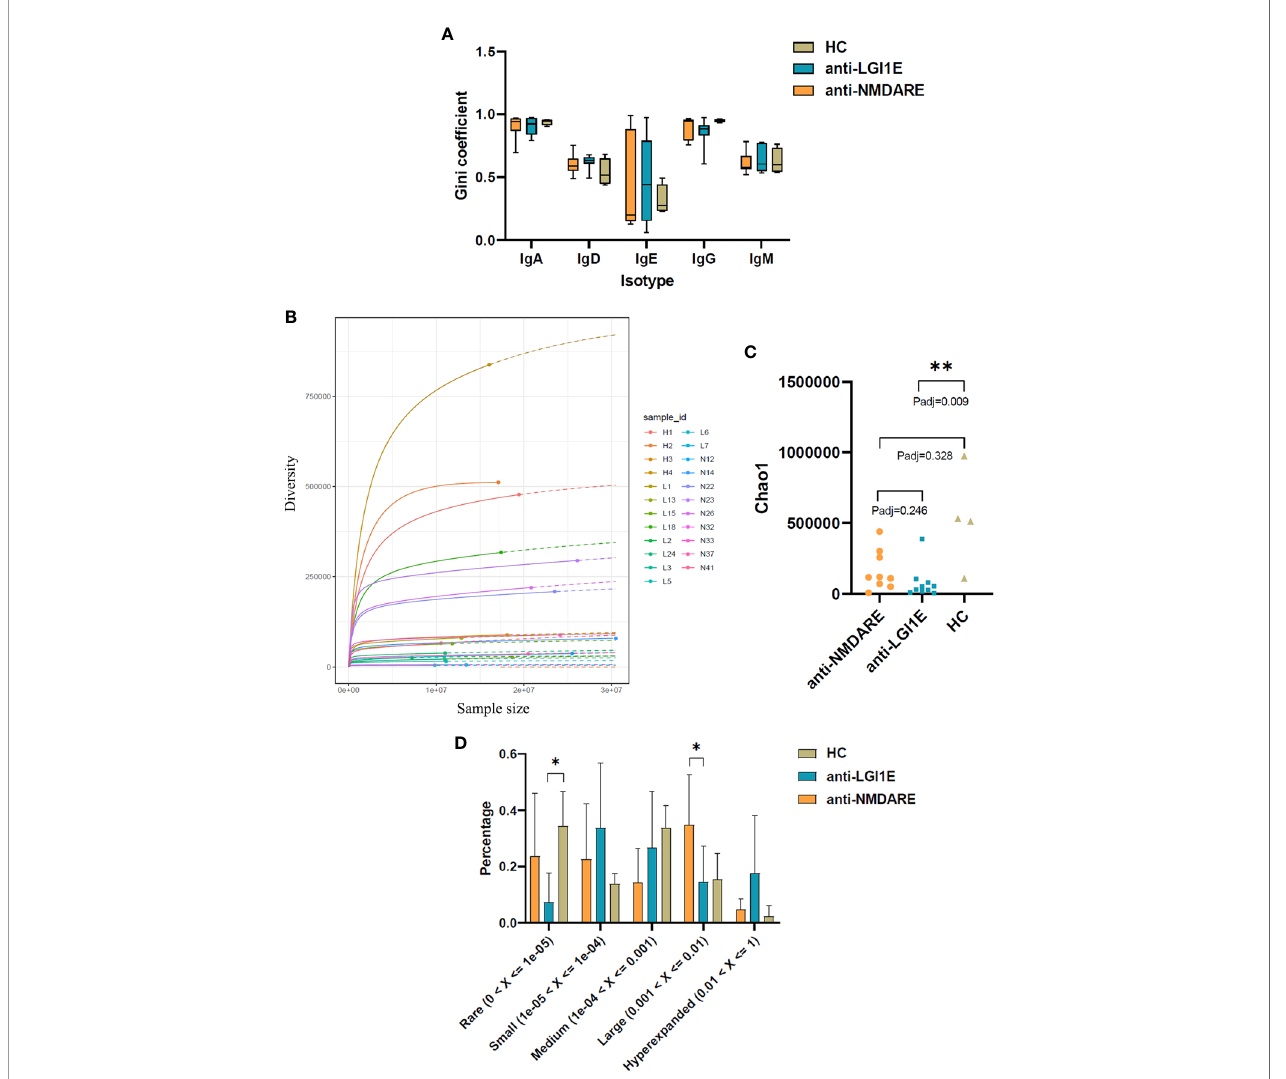
FIGURE 3 | Comparison of the clonal expansion per isotype, diversity, and clonality of the B-cell immune repertoire in peripheral blood samples from the anti-NMDARE, anti-LGI1E, and HC groups using a multinomial model. (A) Gini coef fi cient of each isotype in the anti-NMDARE, anti-LGI1E, and HC groups. (B) Rarefaction analysis of BCRs showing the number of unique clones in a subsample plotted against its size (number of BCR cDNA molecules); solid and dashed lines indicate interpolated and extrapolated regions of rarefaction curves, respectively; points indicate the exact sample size and diversity. (C) Chao1 value of the anti-NMDARE, anti-LGI1E, and HC groups. (D) Analysis of clonality in each group. Anti-NMDARE, anti-N-methyl-D-aspartate receptor encephalitis; anti-LGI1E, anti-leucine-rich glioma-inactivated 1 encephalitis; HC, healthy control; BCR, B-cell receptor. * P adj < 0.05, ** P adj <